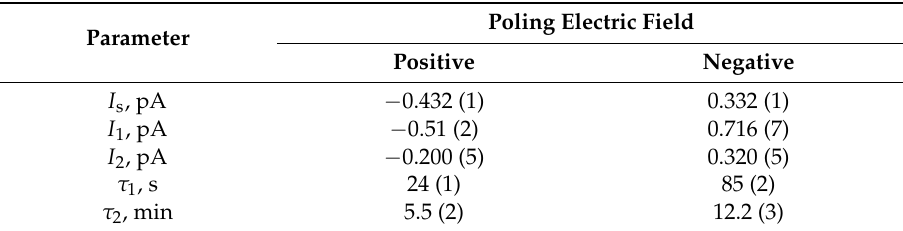
Table 3. Parameters of Equation (4) fitted to short-circuit photocurrent responses of SbSI nanowires to switching on illumination, as shown in Figure 6.